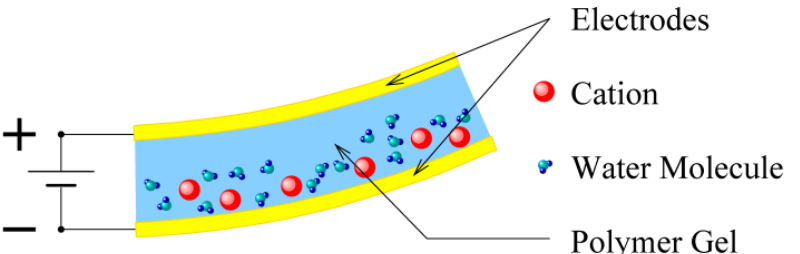
Figure 2. Mechanism for